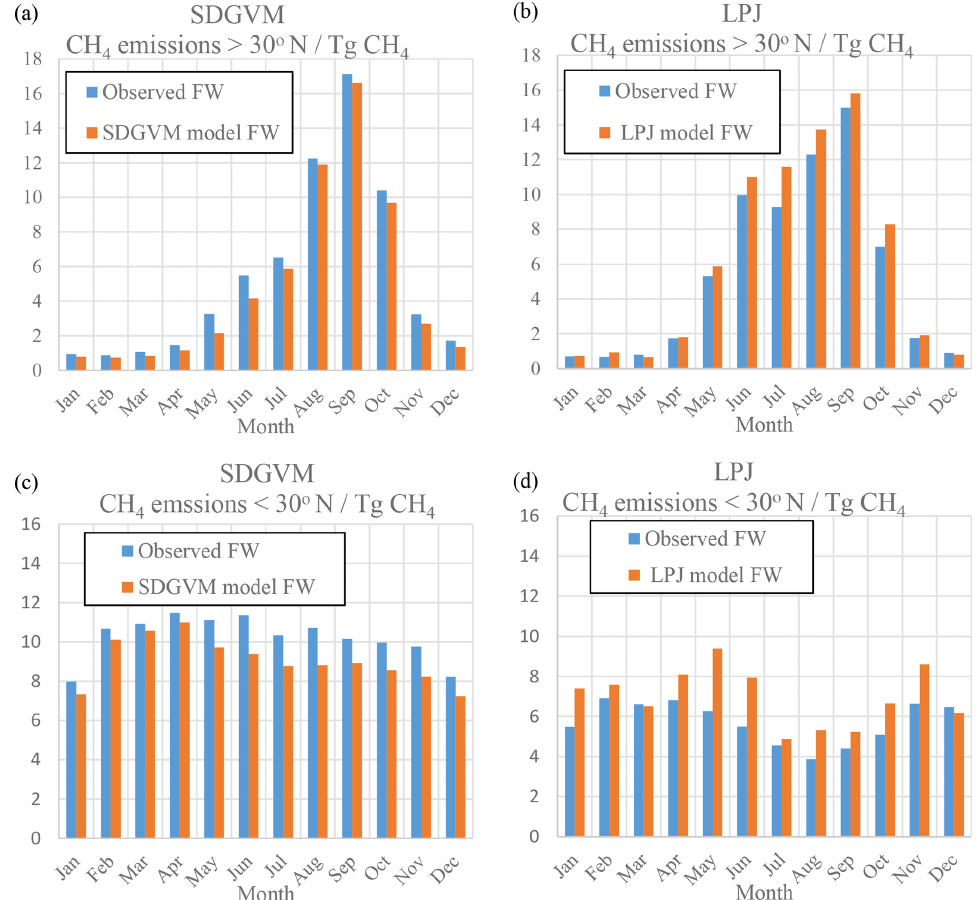
Figure 4. Monthly zonal variations in wetland CH 4 emissions (TgCH 4 ) calculated from DGVM model data and observed or modelled FW for the mean 2000–2012 climate on a 2 . 5 ◦ × 3 . 75 ◦ grid. (a) SDGVM north of 30 ◦ N, (b) LPJ north of 30 ◦ N, (c) SDGVM south of 30 ◦ N and (d) LPJ south of 30 ◦